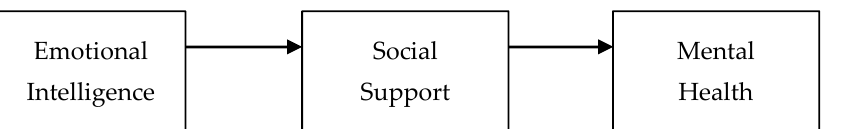
Figure 1. The mediation role of social support (SS) on the emotional intelligence (EI) effects on mental health (MH).